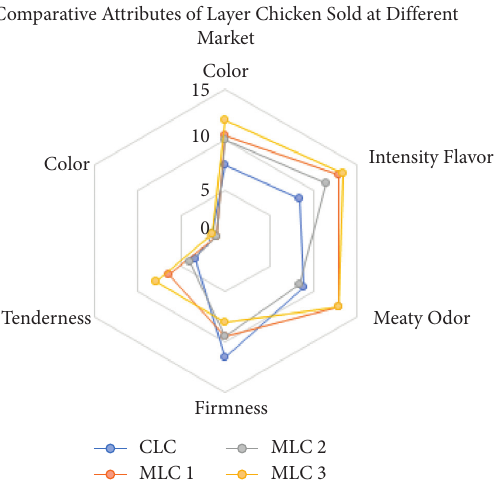
Figure 7: Spider plot of comparative attributes of layer chicken sold at a different market. CLC, control layer chicken; MLC, market layer